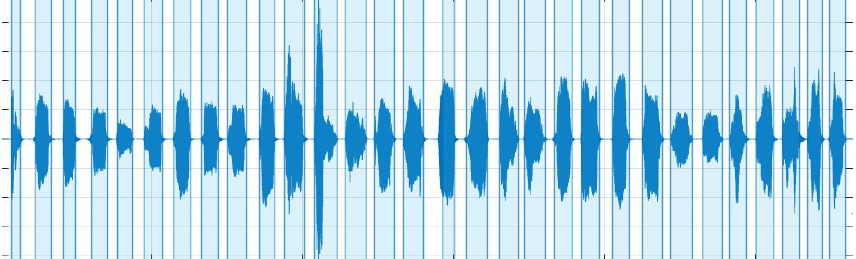
Figure 3. Audio levels are marked according to speech detected in the recorded file before